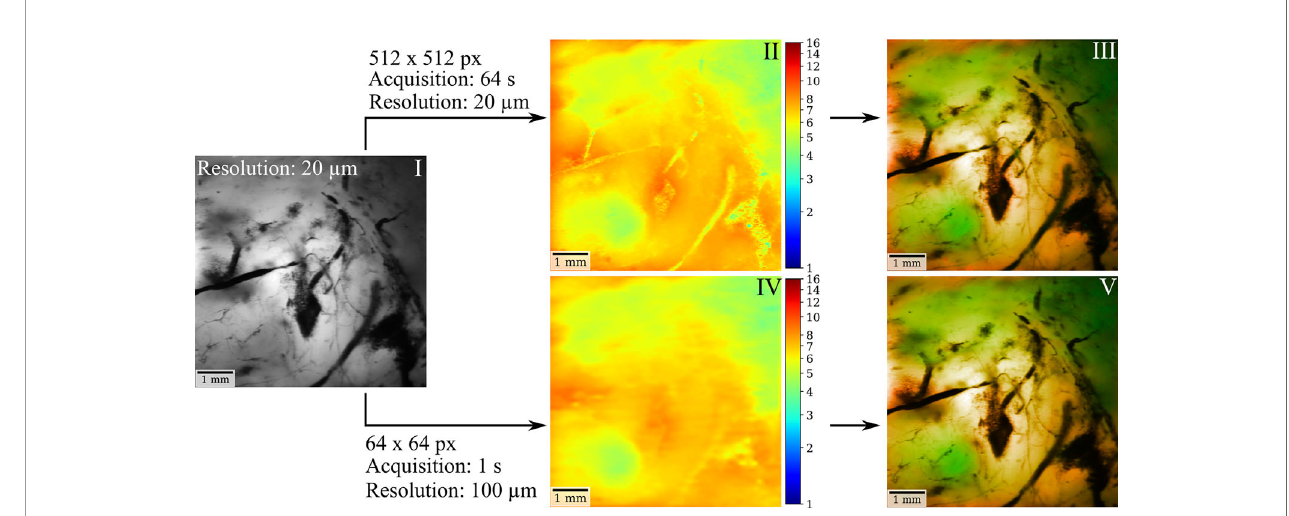
FIGURE 5 | FD-FLIM and structural tissue visualization in surgical microscopes can be achieved through color blending in near real time. Using a highly resolved fl uorescence intensity (I) or a white-light camera image as a basis, color-blending the fl uorescence lifetime (II) provides both structural tissue and lifetime information (III). When reducing the resolution of the FD-FLIM image to 100 µm (IV) acquisition time could be decreased to 1 sec. The corresponding color-blended image (V) yields comparable contrast to (III), with the perceived image quality and resolution being dominated by the luminance of the intensity